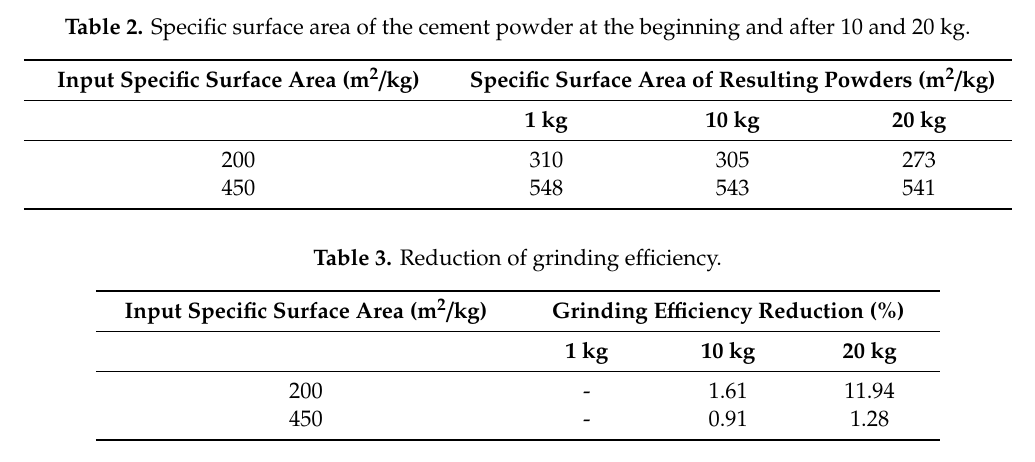
Table 2. Specific surface area of the cement powder at the beginning and after 10 and 20 kg.